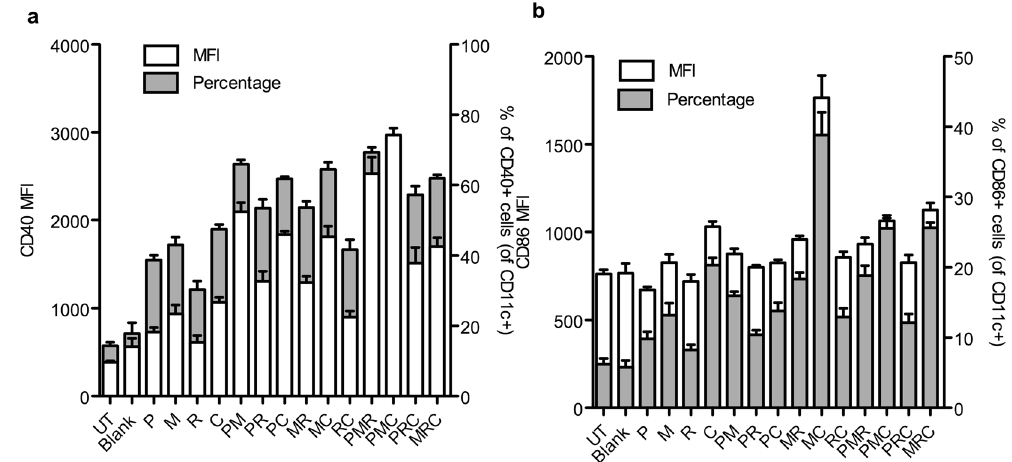
Figure 3. Stimulation of cell surface BMDC activation markers by different PLP combinations. BMDCs were exposed to medium alone (UT) or treated with blank PLP (Blank), 100 ng mL − of PLP-Pam3CSK4